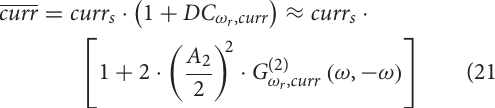
Frontiers in Chemistry |